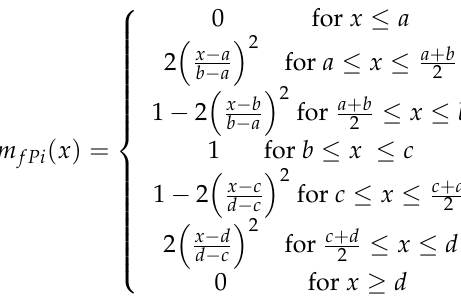
Figure 4. The shape of the MF (Pi FN). In the presented scheme: a and d are the limits of the fuzzy number Fn Pi (upper and lower), and b and c are the modal values of Fn Pi . In order to obtain the risk level, an aggregation operation is performed. The expert opinions obtained are used for this. One of the methods [39] is to use the arithmetic mean aggregation operator. Aggregation is an operator defined in the Gaussian set of fuzzy numbers ( a 1 , b 1 ), ( a 2 , b 2 ), ... ( a n , b n ); n is the number of experts. The result of the activities is the obtained pair in the form ( x , y ) according to Equation (4): ⎩⎪⎨⎪⎧ 𝑥 = 1 𝑛 (cid:3533) 𝑎 (cid:3038)(cid:3041) (cid:3038)(cid:2880)(cid:2868) 𝑦 = 1 𝑛 (cid:3533) 𝑏 (cid:3038)(cid:3041) (cid:3038)(cid:2880)(cid:2868)